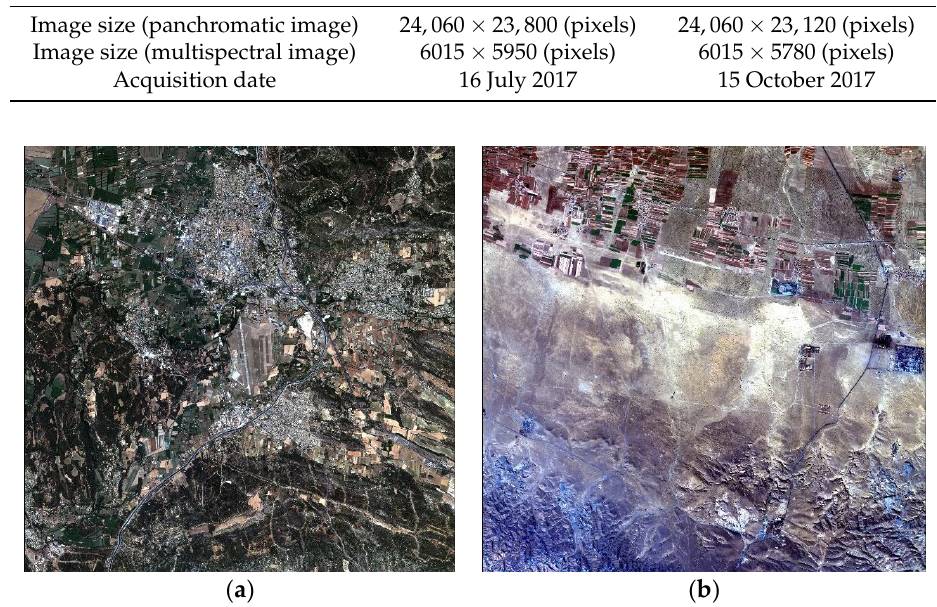
Figure 3. Study areas: ( a ) Salon region, France; ( b ) Baotou region, China.